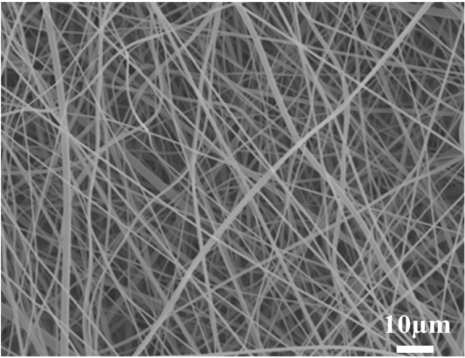
Figure 2. Scanning electron microscopy (SEM) micrograph of the PBT non-woven formed in a labyrinth-like